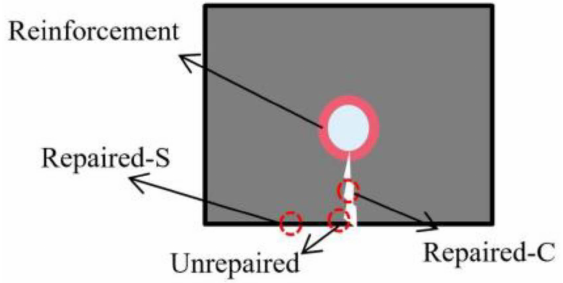
Figure 11. Schematic diagram of sampling location for pore size analysis.